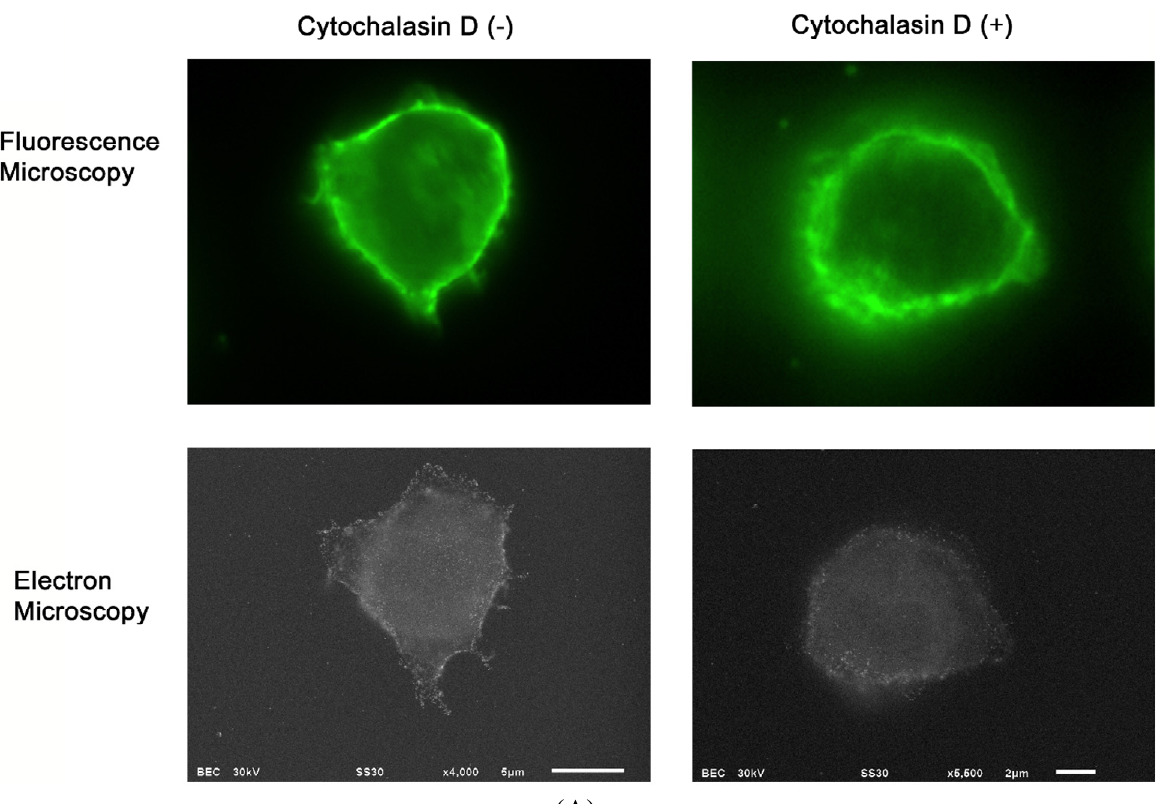
Figure 3. The effect of cytochalasin D on CD44 distribution and activity. ( A ) BW5147 T lymphocytes were left untreated ( left panels ) or treated with 10 µM cytochalasin D on ASEM dishes for 1 h ( right panels ), and fixed with 4% paraformaldehyde. CD44 on the cell surface was labeled with FluorNanogold. The labeled cells were observed by fluorescence microscopy ( upper panels ) or electron microscopy ( lower panels ) after gold enhancement using ASEM at 4000× ( lower left panel ) and 5500× ( lower right panel ) magnifications. Scale bars represent 5 µm ( left panel ) and 2 µm ( right panel ); and ( B ) The effect of cytochalasin D on hyaluronan-binding ability. BW5147 T lymphocytes were treated with 10 µM cytochalasin D ( thick line ) or left untreated ( thin line ) for 1 h at 37 °C, and the extent of FITC-conjugated hyaluronan binding was determined by flow cytometry. Gray filled profile , unstained